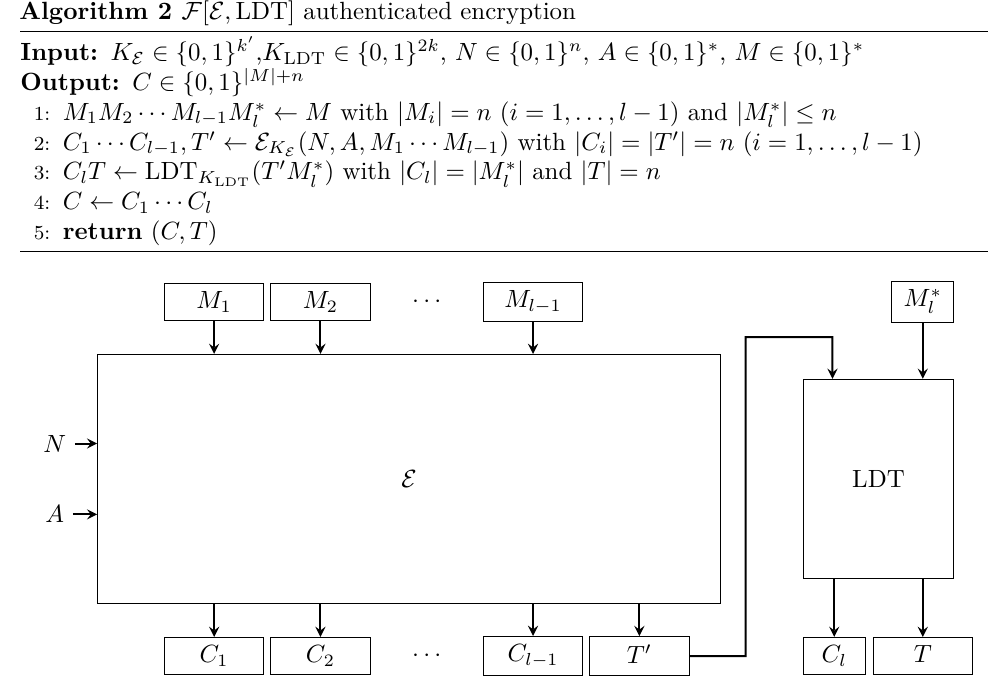
Figure 2: Authenticated encryption F , with E an authenticated encryption scheme for integral data and LDT our length